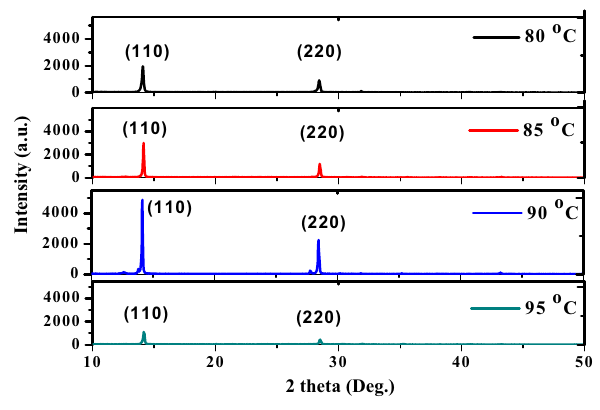
Fig. 4 XRD patterns of the films annealed at 80 °C, 85 °C, 90 °C and